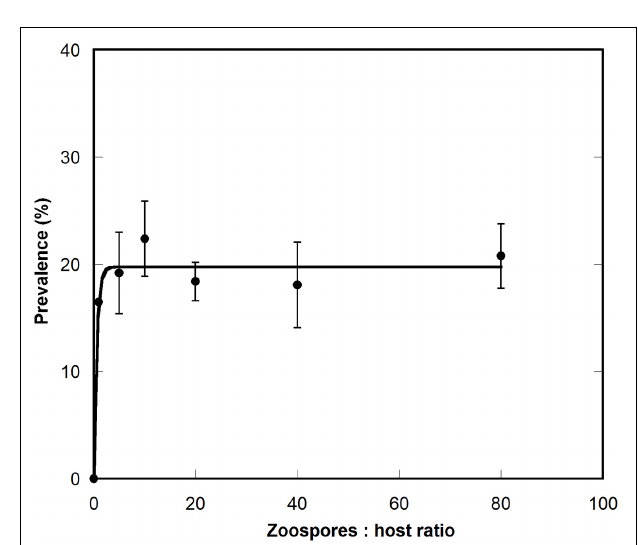
FIGURE 8 | Prevalence curve of Maranthos nigrum infecting the dinoflagellate Alexandrium minutum Arenys strain. The X axis represents the ratio between zoospores and host cells, and the Y axis the percentage of infected cells. Whiskers represent the standard deviation between the three